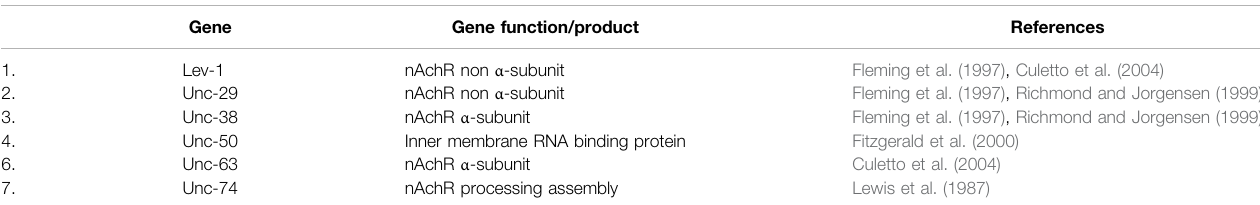
TABLE 2 | Genes exhibiting resistance to Levamisole. Gene Gene